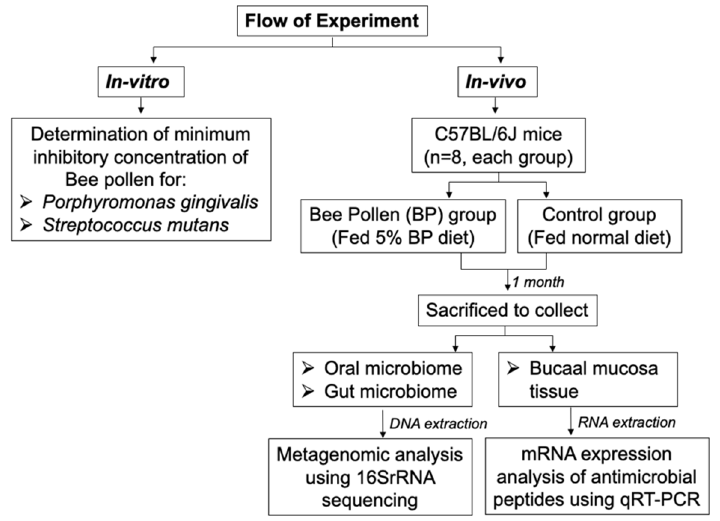
Figure 1. Schematic flow of the experiment .